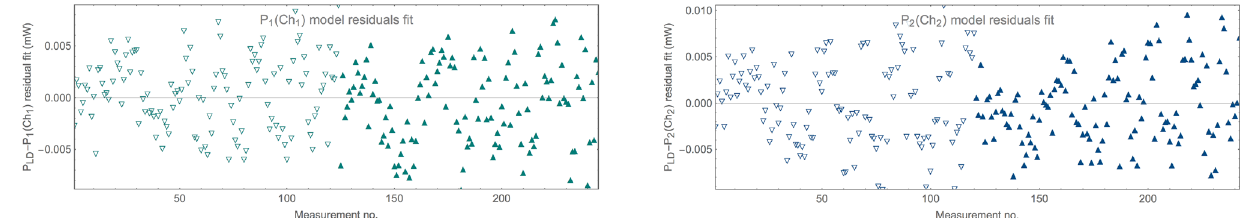
Figure 5. Example of the linear regression residuals—only within the range of points designated for determining the